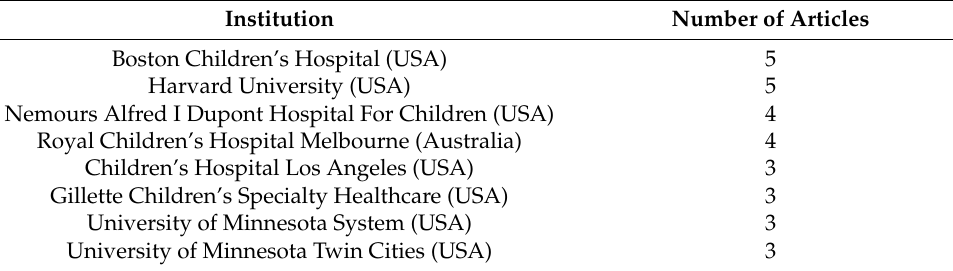
Table 3. Top 8 most productive institutions.